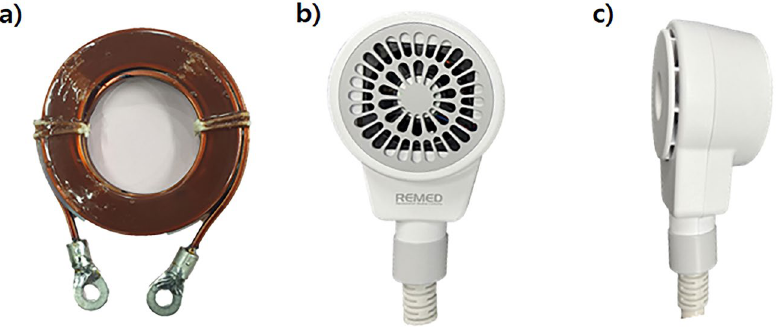
Figure 12. Fabrication of new rTMS coil for murine head model. ( a ) Manufactured coil according to the design; ( b ) front view; ( c ) side view of the manufactured prototype coil in air-cooled casing.